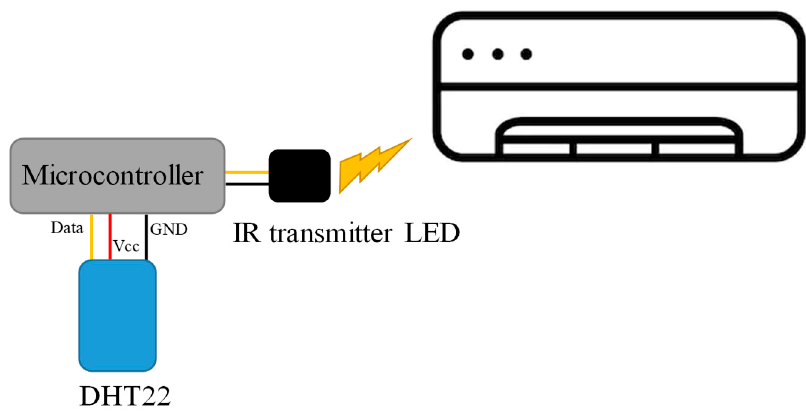
Figure 4. Block diagram of AC controlling subsystem.